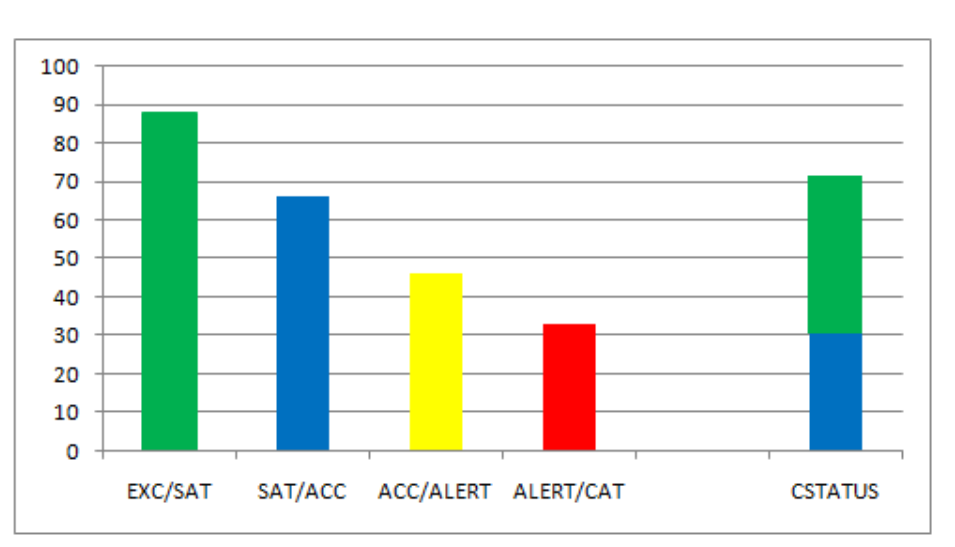
Figure 5. Current status of the department under the green design